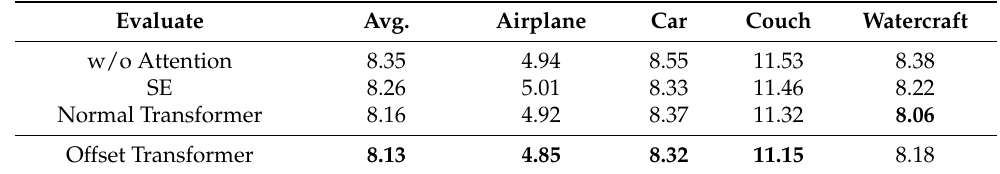
Table 6. The effect of Offset Transformer on network performance in terms of per-point chamfer distance (CD) with L1 norm computed on 16,384 points and multiplied by 10 3 . The best results are highlighted in bold (lower is